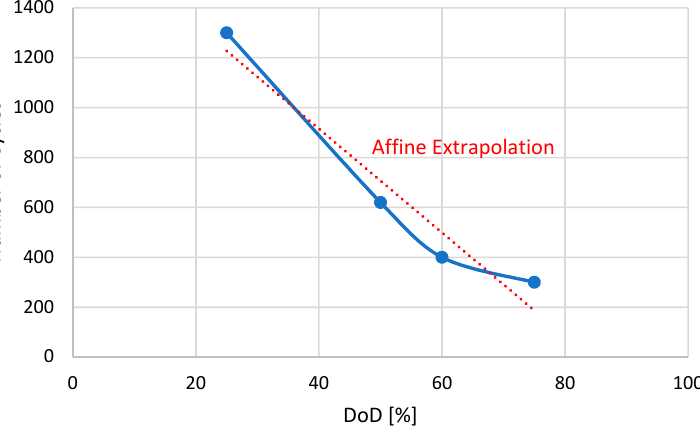
Figure 3. A linear trend extrapolation of BAT SOH according to DOD variation [28].